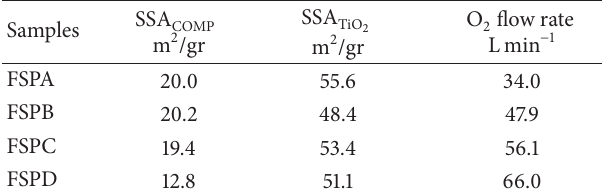
Table 2: Measured BET SSA of the TiO calculated SSA of their TiO oxygen flow